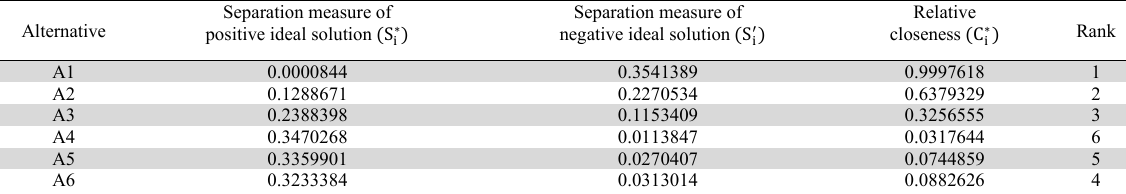
Separation measures of positive and negative ideal solutions, relative closeness and rank Separation measure of Alternative positive ideal solution (S (cid:2919)∗ )